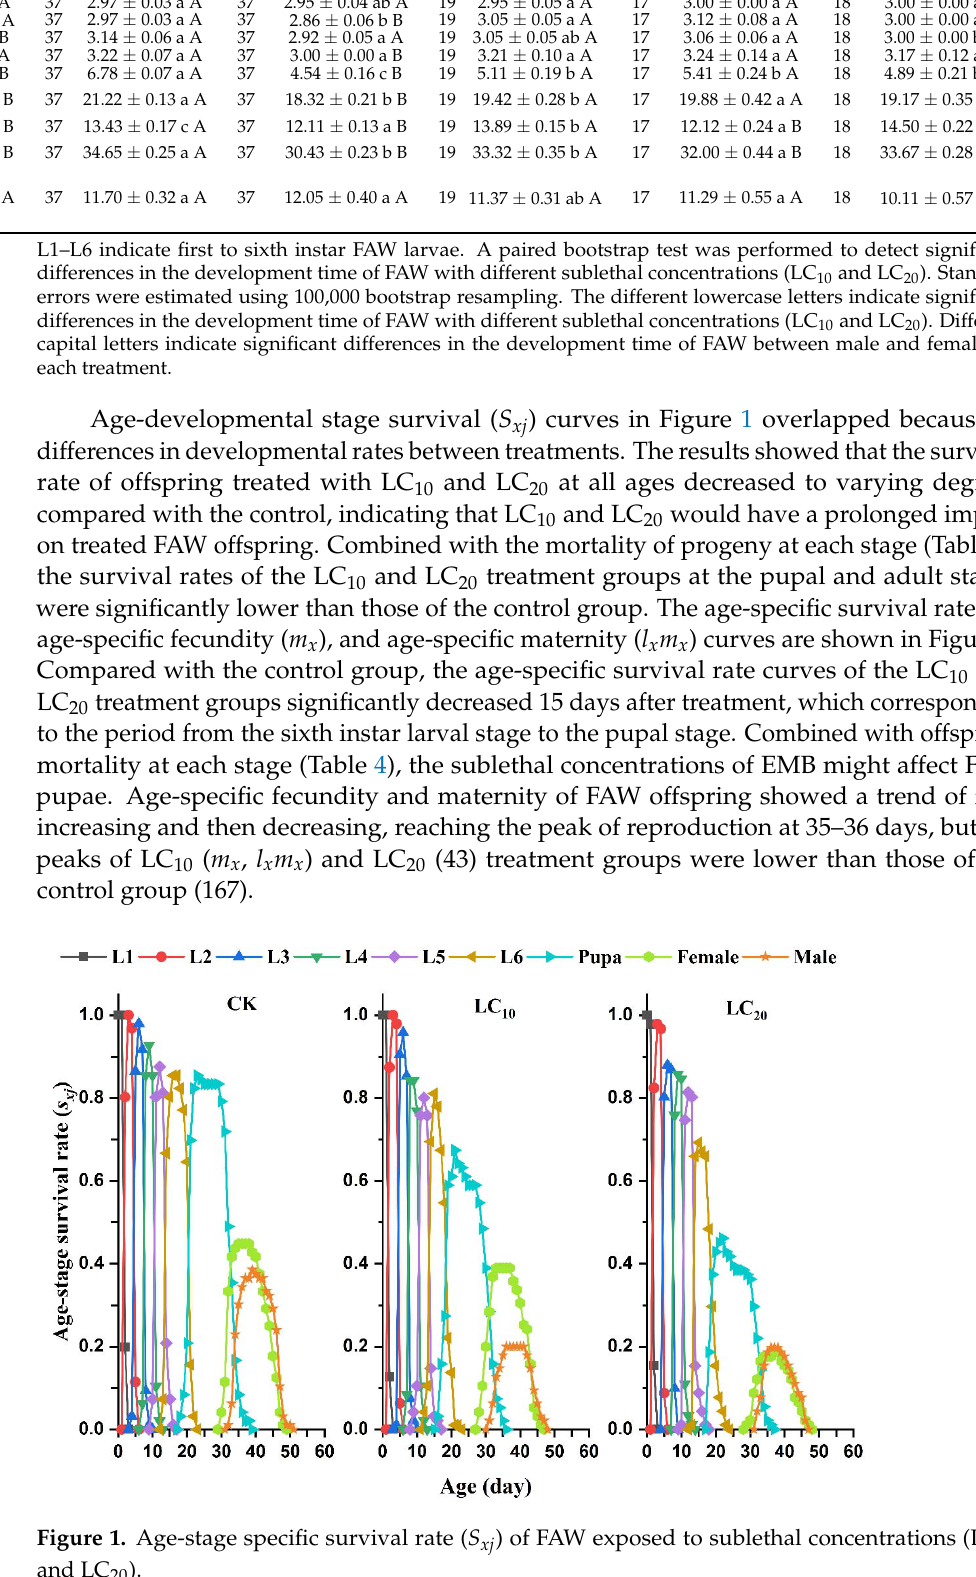
Figure 2. Age-specific survival rate ( l x ), age-specific fecundity ( m x ), and age-specific maternity ( l x m x ) curves of the FAW offspring generation from the FAW parental generation exposed to sublethal concentrations (LC 10 and LC 20 ). 3.4. Sublethal Effects of EMB on the Reproduction Parameters of the FAW Offspring Generation Sublethal concentrations (LC 10 and LC 20 ) that did not influence the total pre-oviposi- tion of FAW F 1 are listed in Table 6. The life expectancy ( e xj ) was higher in the control